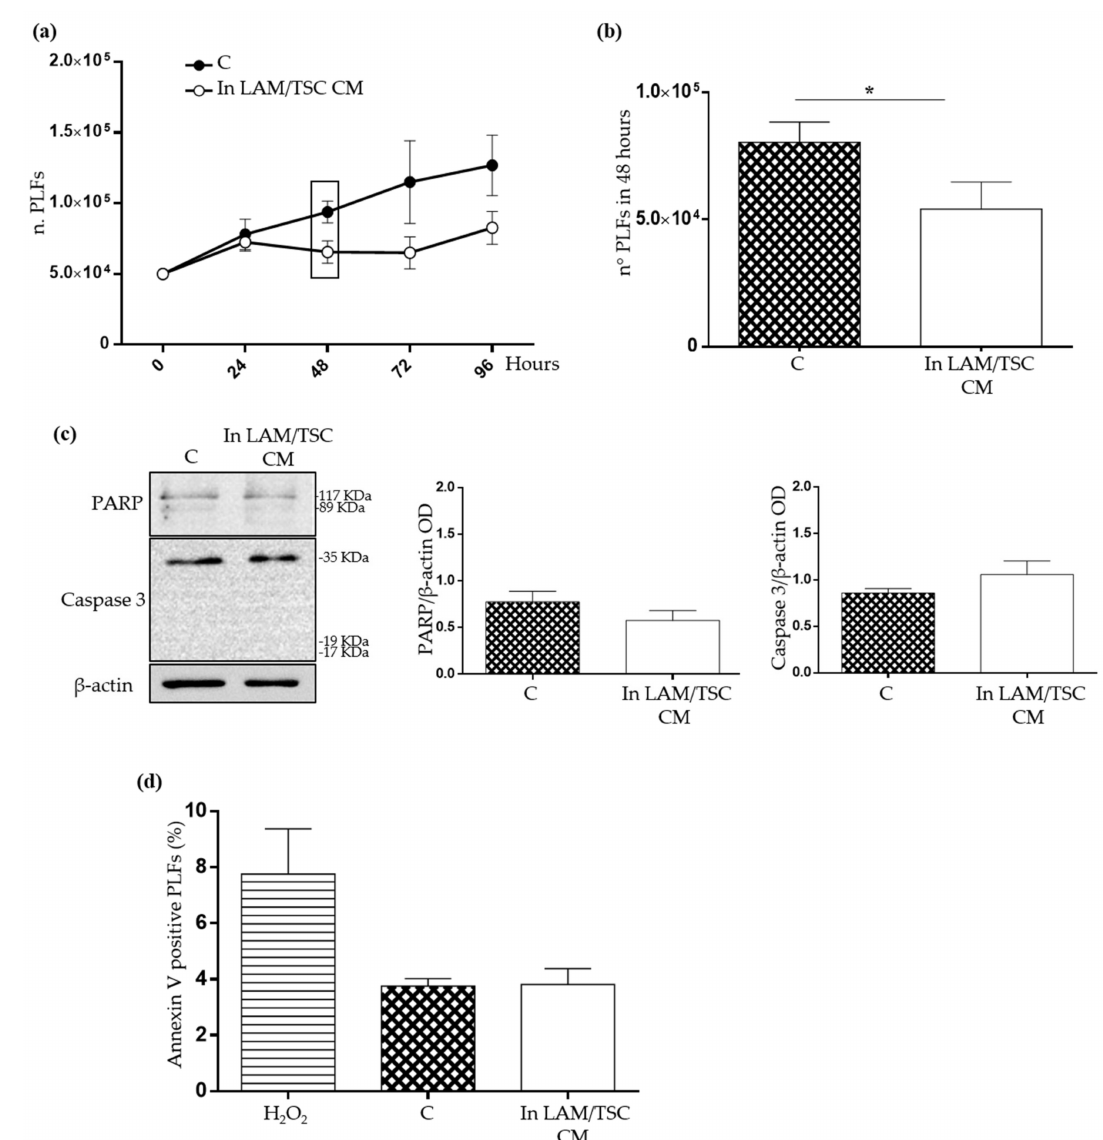
Figure 4. Proliferation of PLFs in LAM/TSC cell CM ( a ) Growth of PLFs cells was evaluated at 24, 48, 72, and 96 h in their own CM (C) or in LAM/TSC cell CM (LAM/TSC CM). The rectangle indicates the 48 h-time point. Each data point shows the mean ± SEM ( n = 4). ( b ) The histogram highlights the number of PLFs (C) and PLFs in LAM/TSC cell CM after 48 h of growth. Results are shown as mean ± SEM ( n = 4). Student’s t -Test, * p < 0.05 ( c ) PARP and Caspase 3 expression was analysed in PLFs cells grown for 48 h in their own CM (C) and in LAM/TSC cell CM. β -actin was used as loading control. Anti-Caspase 3 antibody and anti-PARP antibody recognize both the full length and the cleaved form of the protein (the molecular weight of the full-length protein and of its expected cleaved fragments are indicated on the right of the image). Representative images of 3 independent experiments are shown. The histograms on the right represent the densitometric analysis of the relative expression of PARP and Caspase 3 normalized on β -actin. Results are shown as mean ± SEM ( n = 3). Student’s t -Test, ns ( d ) Flow cytometry analysis of annexin positive PLFs cells was performed in cells grown for 48 h in their own CM (C) or in LAM/TSC cell CM. The induction of apoptosis by treating PLFs with 500 µ M Hydrogen Peroxide (H 2 O 2 ) for 2 h was used as positive control. Results are shown as mean ± SEM ( n =